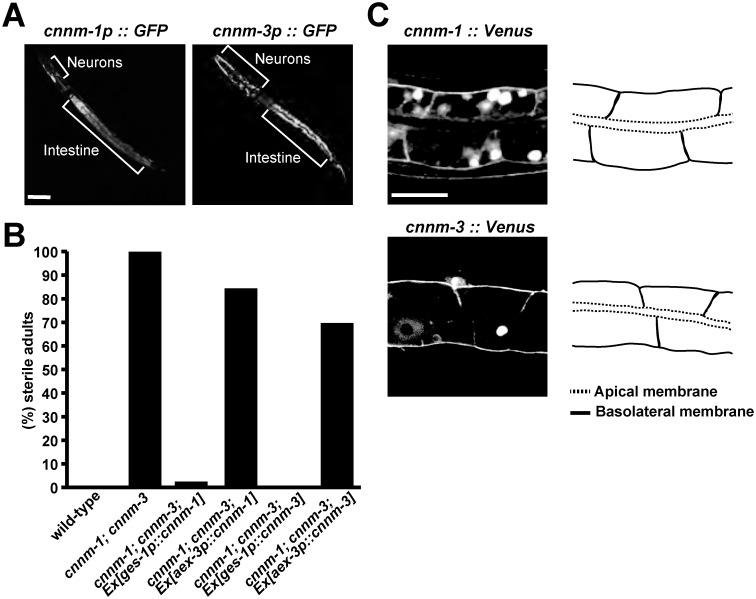
Localization of CNNM-1 and CNNM-3 at the basolateral membrane of intestinal cells.(A) Fluorescent images of wild-type L1 larvae with cnnm-1p::GFP or cnnm-3p::GFP. Areas of neurons and intestines showing strong GFP signals are marked. Bar, 30 μm. (B) Quantification of sterile phenotype in wild-type, cnnm-1; cnnm-3 mutants, and cnnm-1; cnnm-3 mutants expressing either CNNM-1 or CNNM-3 under the control of the promoters for intestinal (ges-1p) or pan-neuronal (aex-3p) markers. More than 50 worms were analyzed for each genotype. (C) Fluorescent images of intestinal cells from wild-type L1 larvae expressing the Venus-fusion proteins of CNNM-1 or CNNM-3 (left). Schematic representation of the intestinal cell plasma membranes are also shown (right). Apical and basolateral membranes are indicated by dotted and solid lines, respectively. Bar, 10 μm.